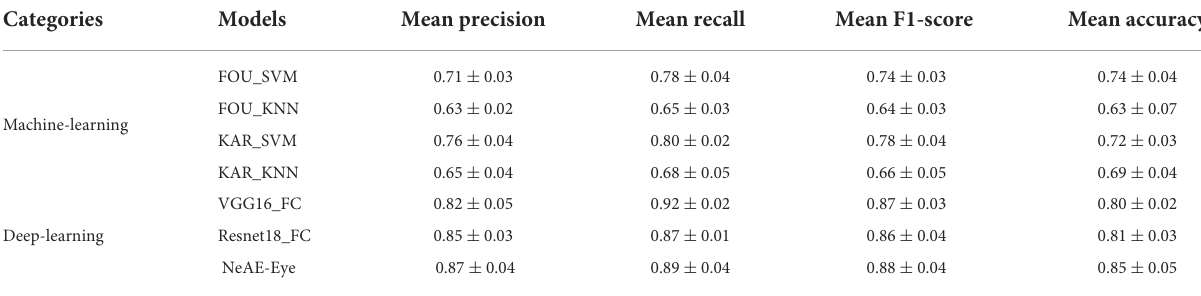
TABLE 1 Results comparison with the state-of-the-art